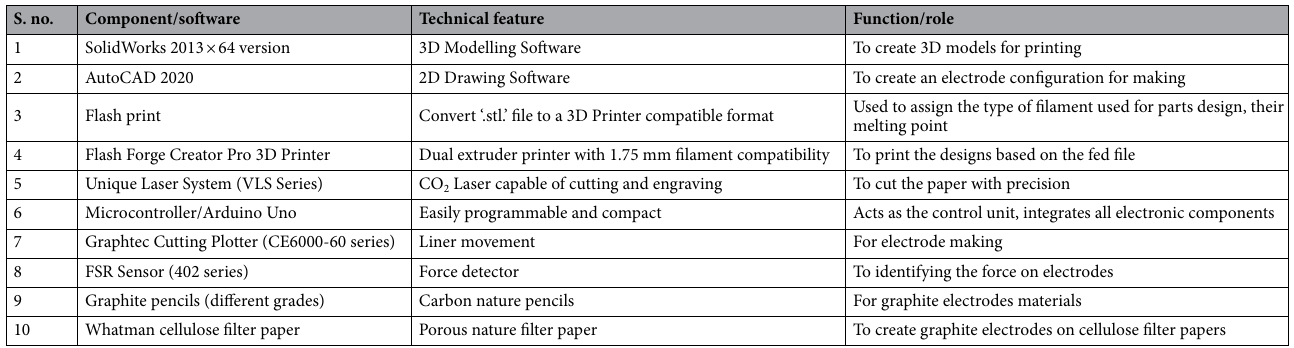
Table 2. Detail description of an automated pencil holder device